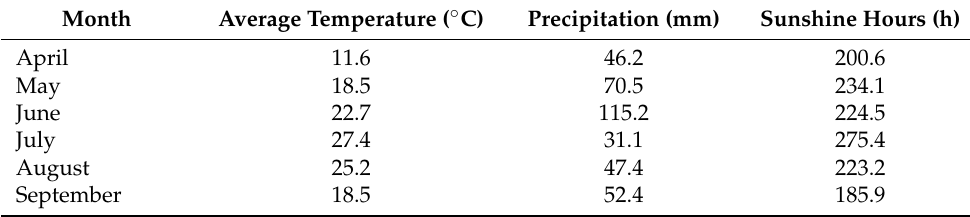
Table 1. Daily mean values of the weather variables at the experimental site during the six months of the maize growing season in